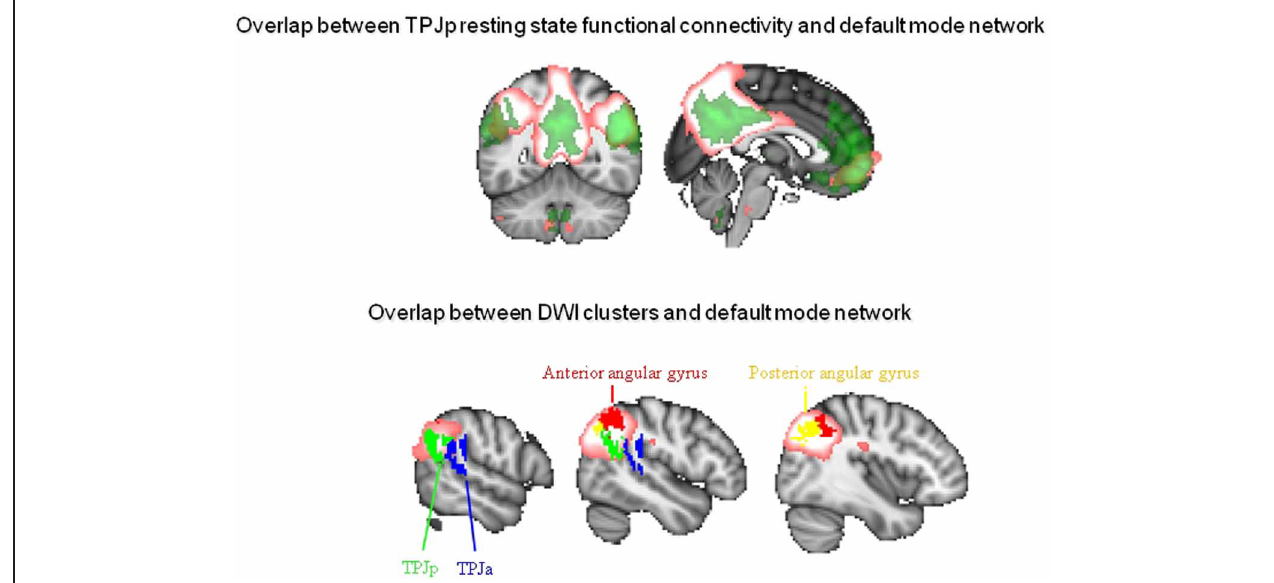
independent component analysis in pink. Bottom: Overlap between the DMN in pink and the anterior (TPJa) and posterior (TPJp) areas from Mars et al. (in press) and the anterior and posterior angular gyrus from Mars et al.